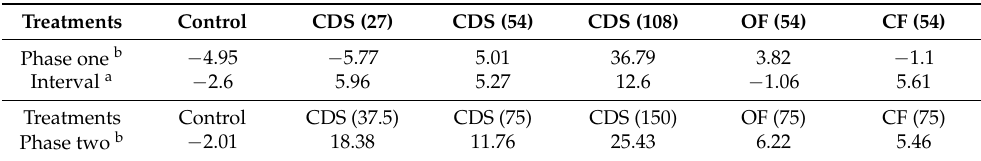
Table 7. Soil HN loss of the treatments in phase one and two (mg/kg).